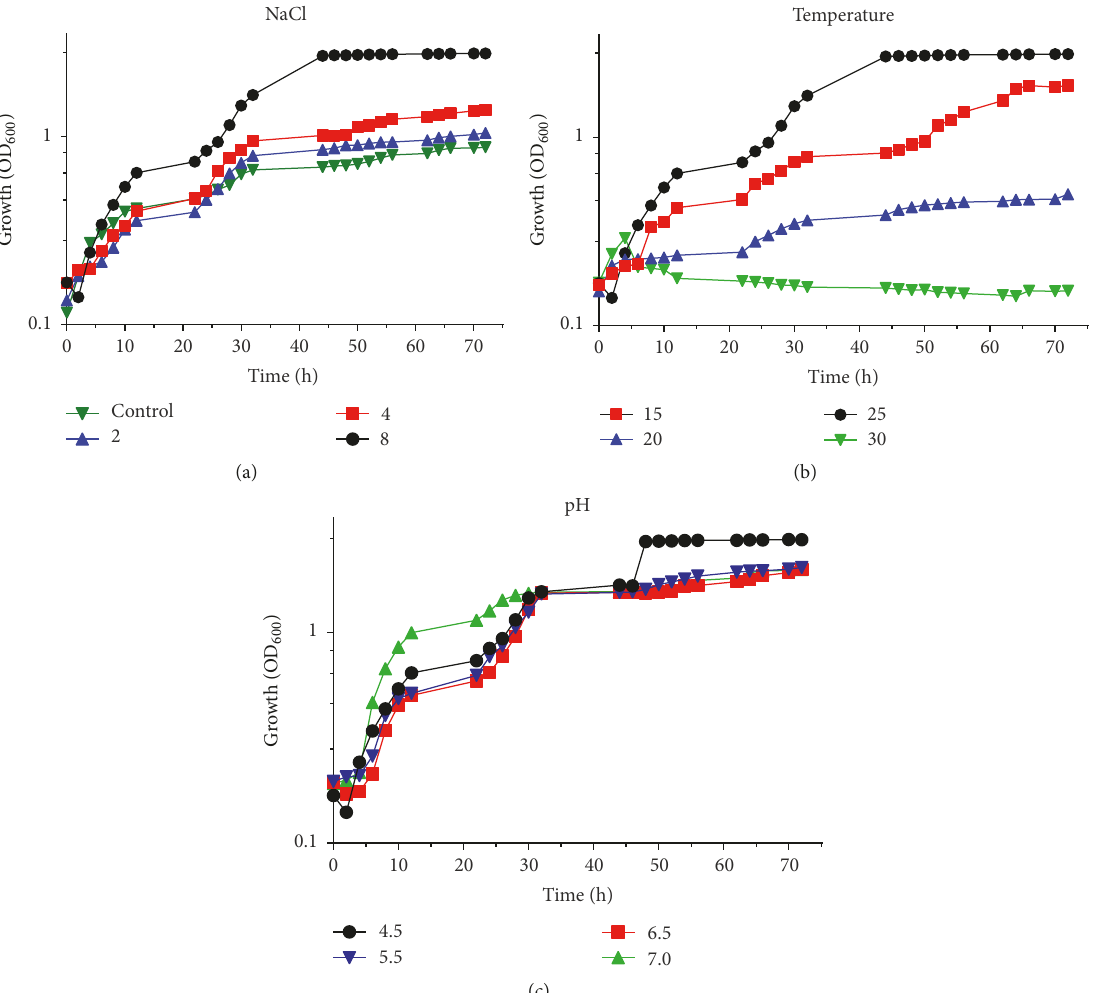
Figure 6: Growth curve of D. hansenii DSMZ70238. D. hansenii DSMZ70238 was cultured in growth media under different conditions for 72 h. (a) The growth of D. hansenii DSMZ70238 with different concentrations of NaCl, (b) the growth under different temperatures, and (c) growth of D. hansenii under different pH